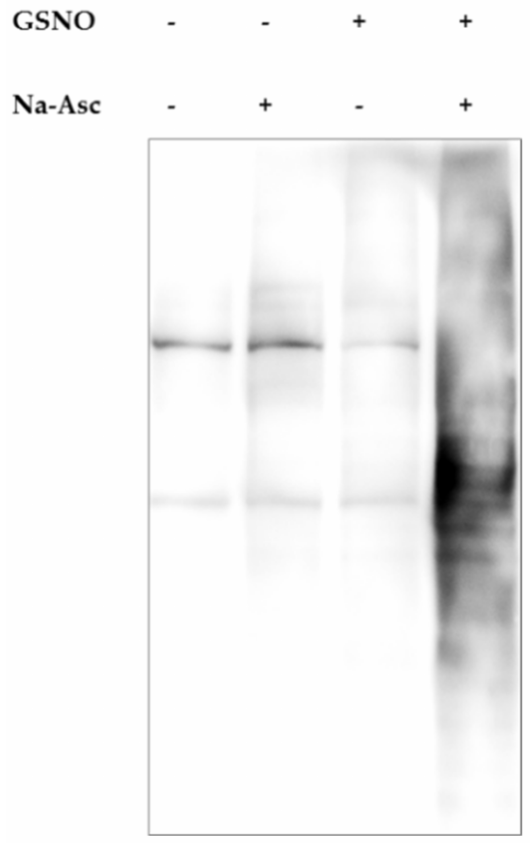
Figure 22. Representative results demonstrating specificity of biotin switch assay. Lysates of the prefrontal cortex were incubated for 30 min with (or in the absence of) 200 µ M S-nitrosoglutathione (GSNO), a NO donor. During the labeling step with or without the addition of sodium ascorbate (Na-Asc), biotinylation of the nascent thiols occurred. The sample treated with both GSNO and Na-Asc showed a strong signal compared to other control